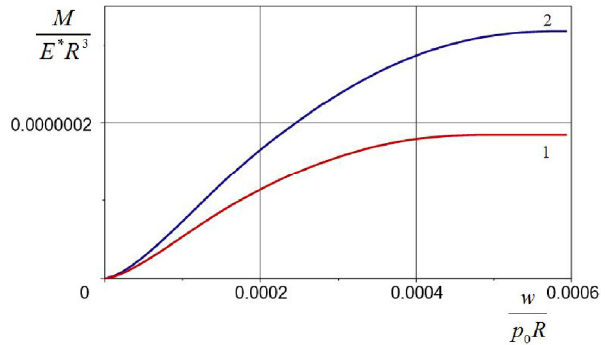
Fig. 9 Moment of rolling resistance vs dimensionless work of